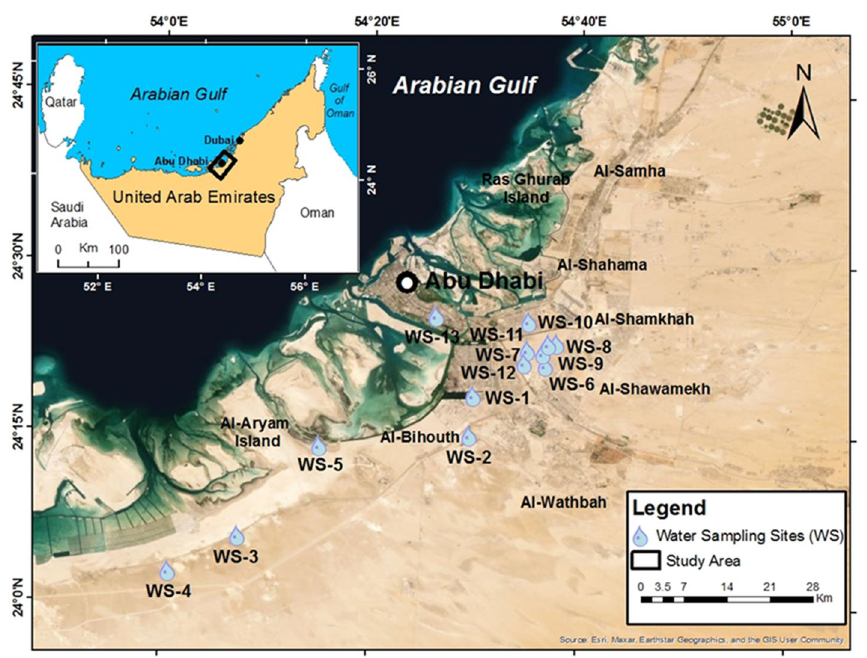
Figure 2. Groundwater sampling sites of the study area and surroundings areas (generated with ArcGIS 10.8 27